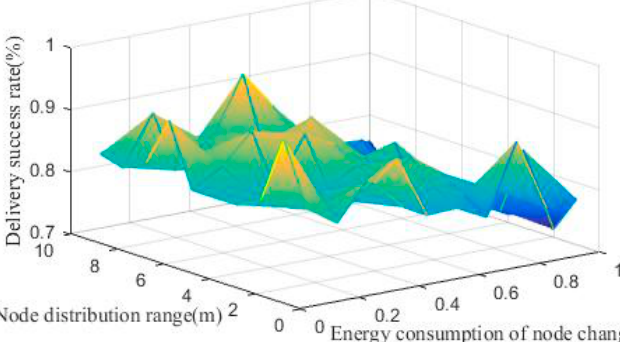
Figure 8. The influence of node change energy consumption and node distribution range on delivery success rate.